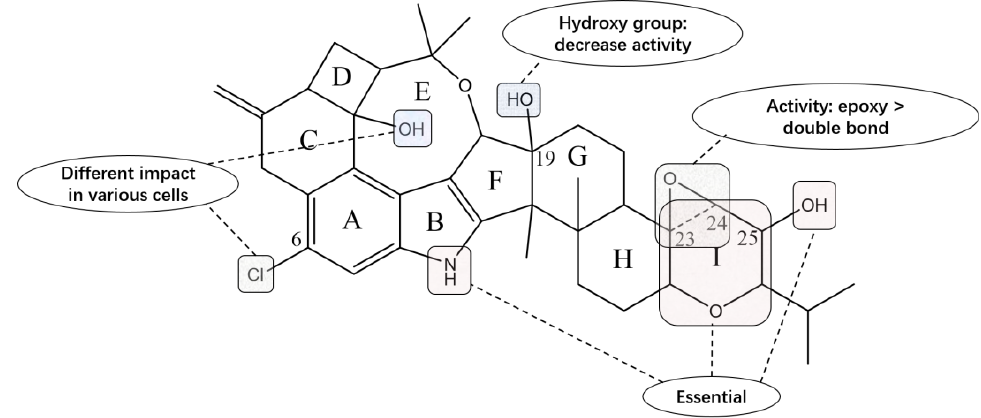
Figure 17. Structure – activity (anti-cancer) relationship of penitrem indole diterpenes. Exploration of M. irregularis QEN-189 has led to 20 indole diterpenoid compounds, whose antitumor activities were all estimated against the HL-60 and A549 cell lines (Table 1) [67]. Most of the compounds showed weak or no activity towards these two cell lines aside from rhizovarins A-B, penitrems A-C, F and compound 6 . It was noticeable that the chlorinated derivatives had stronger activity than their chlorine-free counterparts. This observation hints that chlorine substitution can increase the activity against these cell lines. On the other hand, compound 6 , lacking a 13-hydroxy group and 10-keto, showed apparent activity in this assay compared to paxilline. Compound 8 was inactive, indicat- ing the importance of 10β -hydroxy of paxilline-type indole diterpenes taking effect. Table 1. Antitumor activity of indole diterpenes (IC 50 , µ M). Reproduced with permission [67]. Copyright 2016, American Chemical Society.